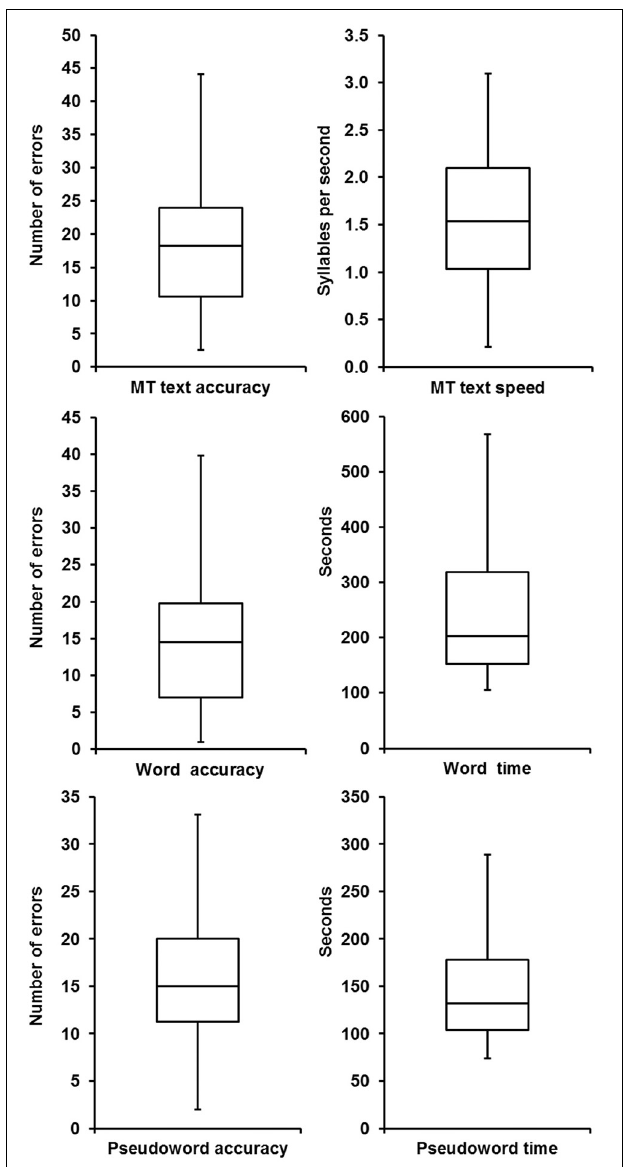
FIGURE 1 | Box plots of the reading outcomes. The bottom and top of the box show the first and third quartiles, the band inside the box the median. The edges of the whiskers represent the values closest to the median between the minimum absolute value and Q1 − 1 . 5IQR for the lower whisker, and the maximum absolute value and Q3 + 1 . 5IQR for the upper whisker, where Q1 and Q3 are the first and third quartiles respectively, and IQR is the interquartile range.